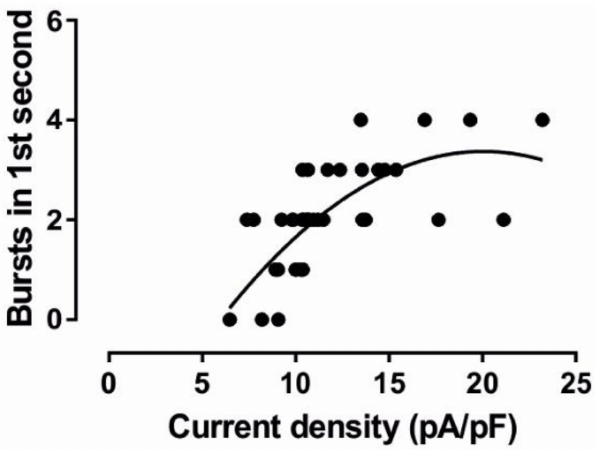
Figure 13. The Spearman correlation analysis with a polynomial fit of I h current density ( x -axis) obtained from voltage–clamp recordings and the number of bursts generated by the computer model within the first second ( y